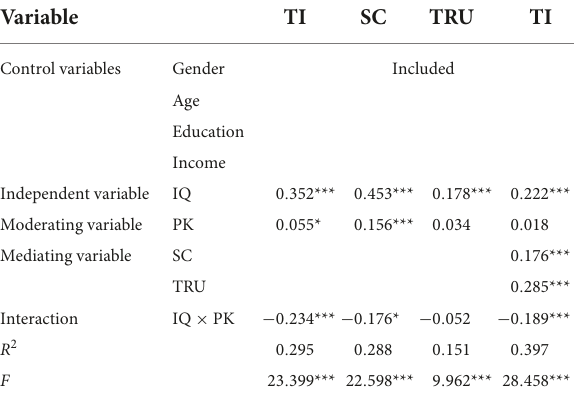
TABLE 6 Moderating effect test.